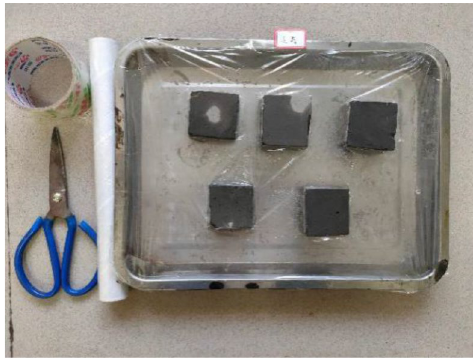
Figure 17. Frost testing process.